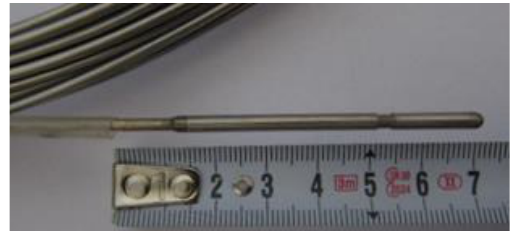
Fig. 1. CEA Cadarache manufactured miniature fission chamber.